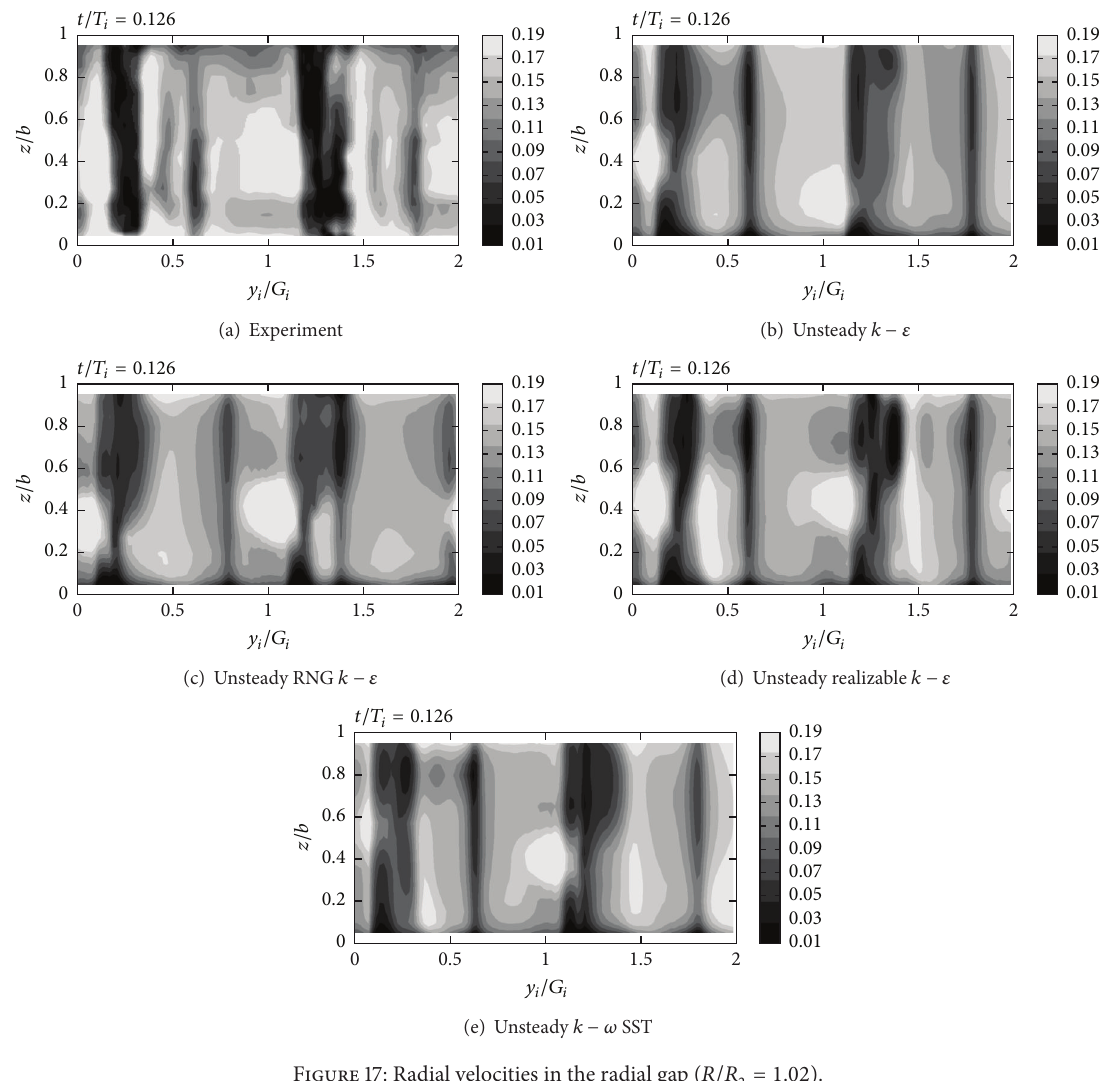
Figure 17: Radial velocities in the radial gap ( 𝑅/𝑅 2 = 1.02